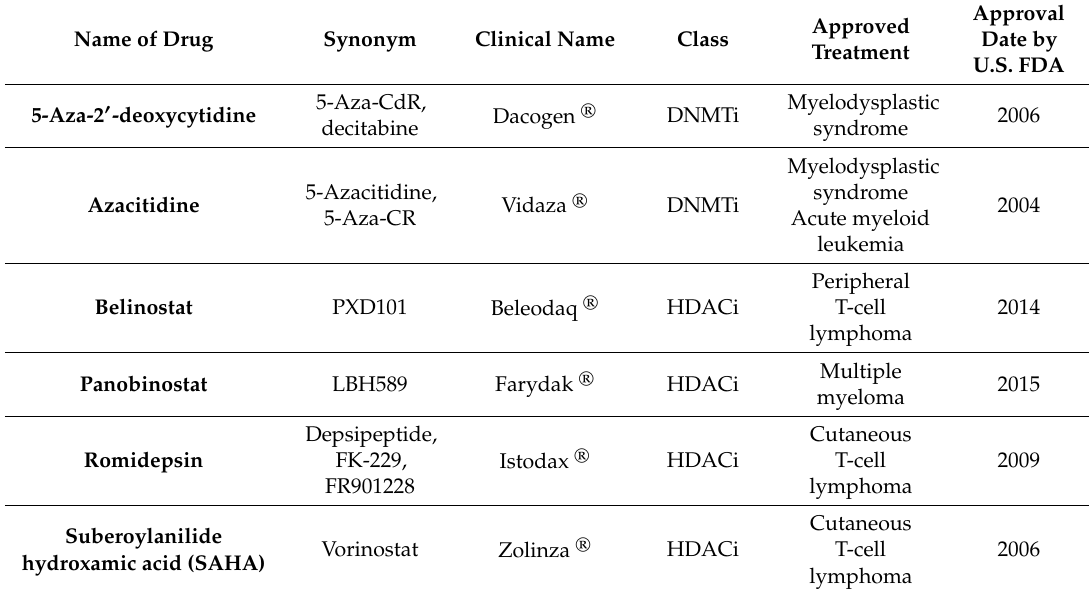
Table 3. Epigenetic drugs approved by the U.S.